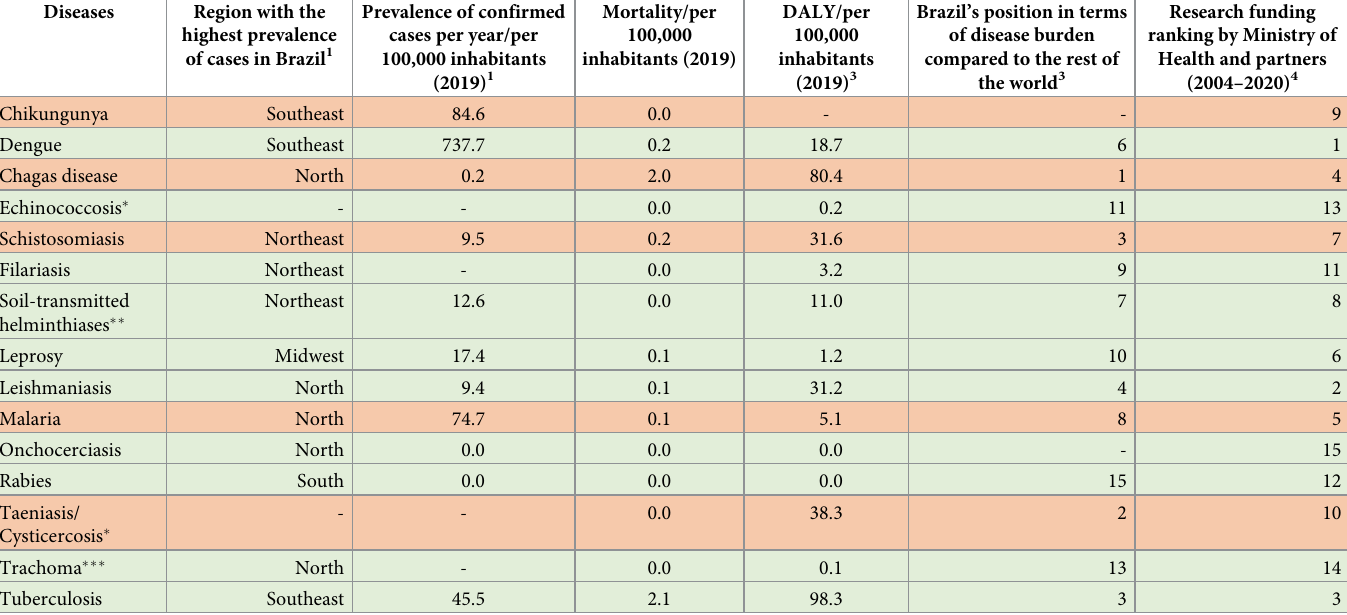
Table 1. Comparison of prevalence, mortality rate, years of life lost and amount funded by Ministry of Health and partners for research on neglected tropical dis- eases. Brazil, 2019. Diseases